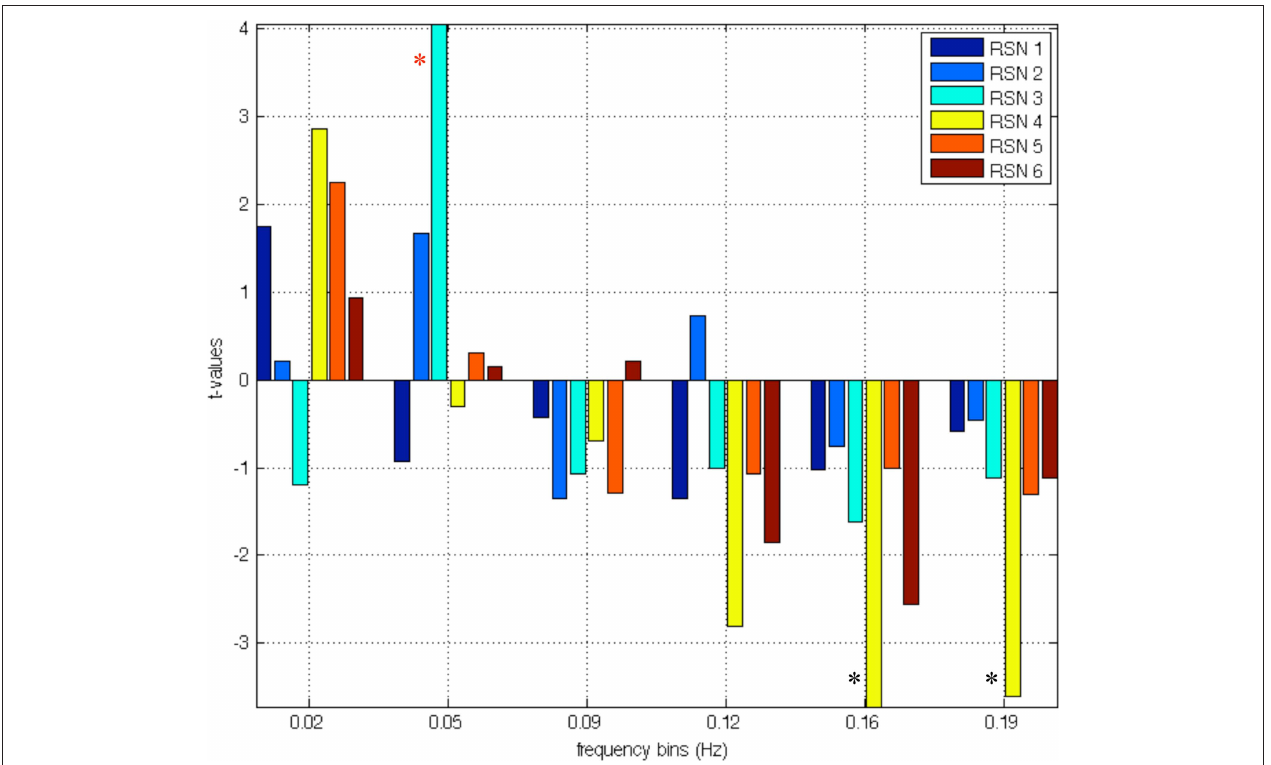
FIguRe 2 | (C) Correlation between relevant RSNs frequency bins and scores at the disorganized factor; the red asterisk indicates significant correlations with RSN 3 (VN); the black asterisks indicate negative correlations with disorganized factor and hypo-connectivity of RSN 4 (AN).